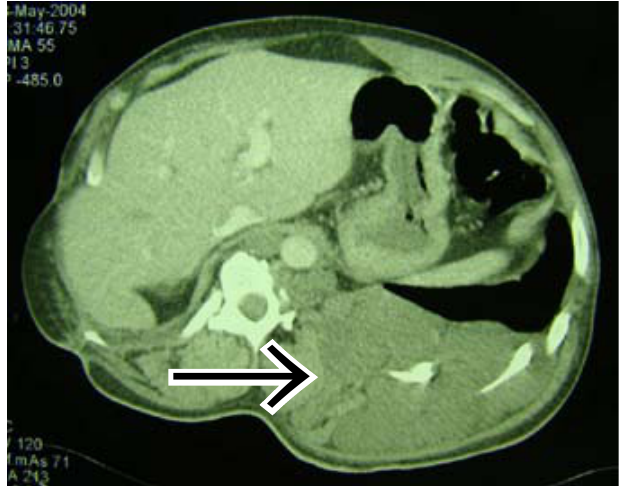
Fig. 10. CT scan of the preceding patient showing a large plexiform neurofi- broma on the left side, causing spine and rib changes.